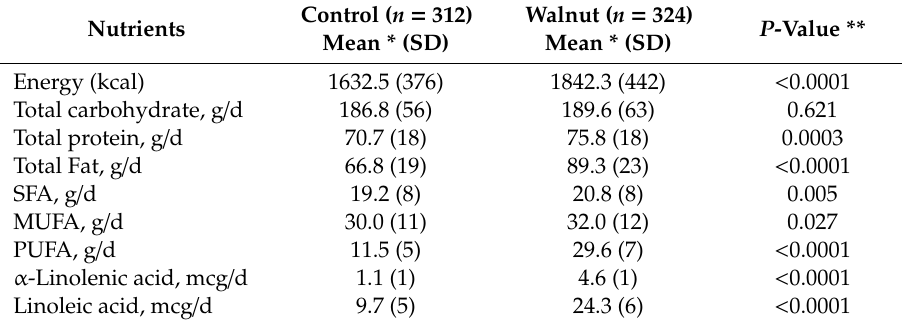
Table 2. Mean daily intake of selected nutrients in the walnut and control groups at two